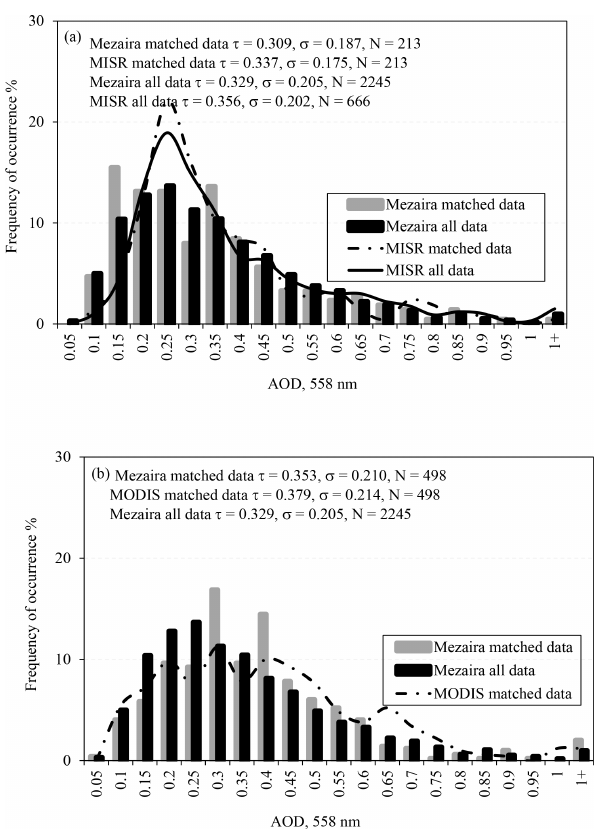
Figure 7. Histogram of the MISR, MODIS, and Mezaira AERONET measurements (a) MISR and (b) MODIS data re- trievals.